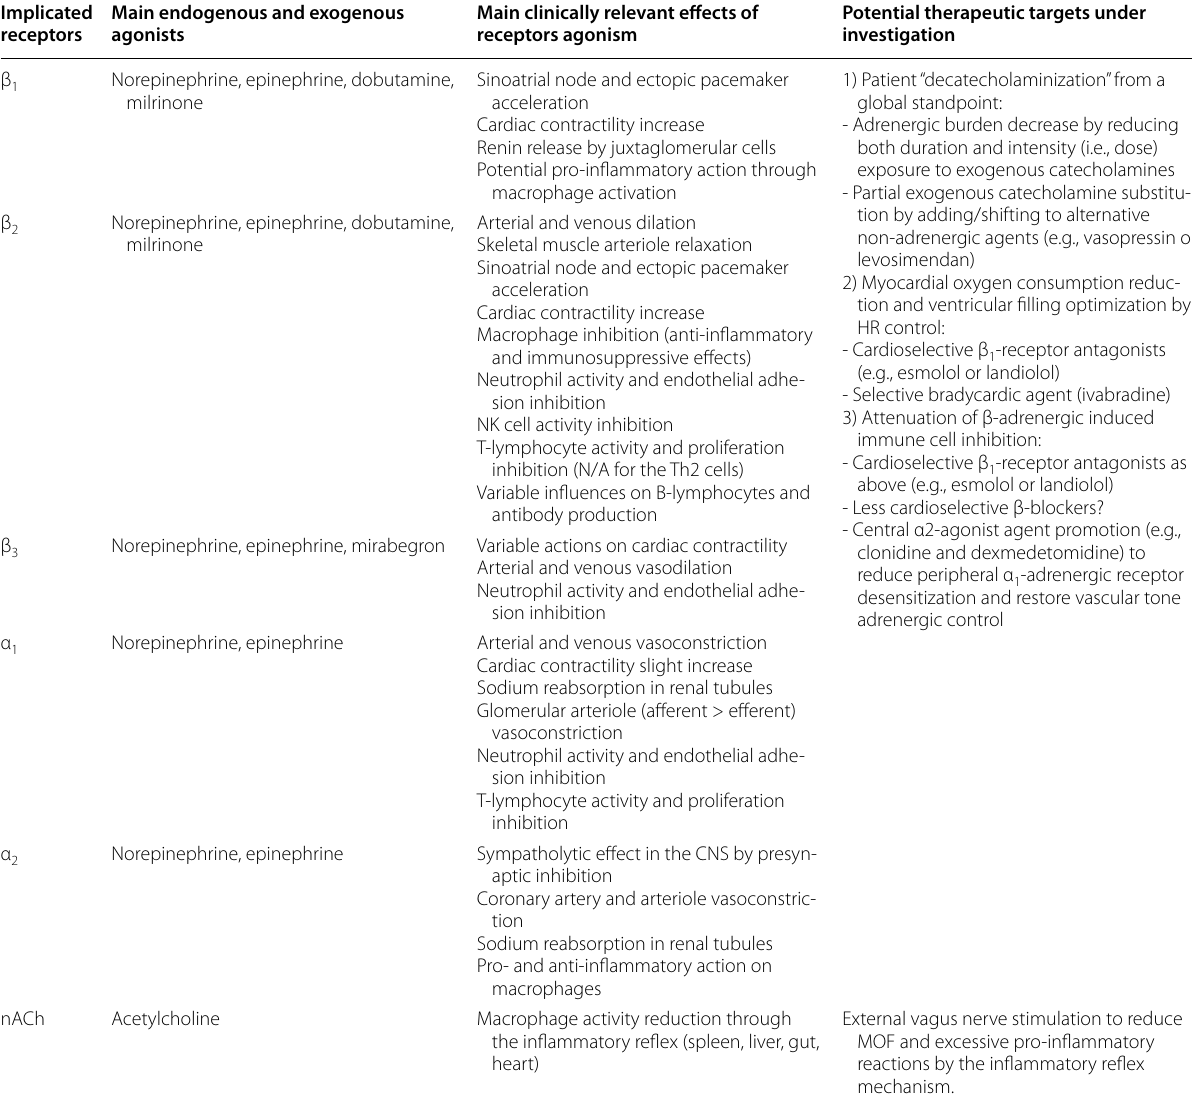
Table 2 Mechanisms affecting the ANS that provide clinically relevant effects and may represent potential therapeutic targets during